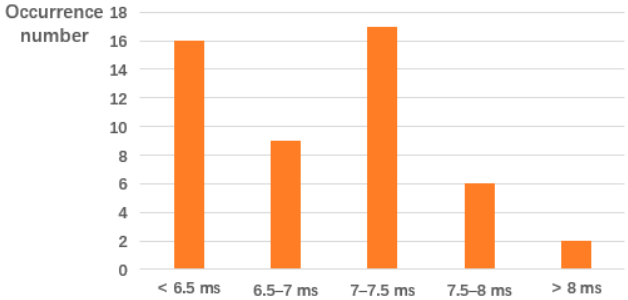
Figure 9. Distribution of data response time when the requested data exist in Ba-ITS.